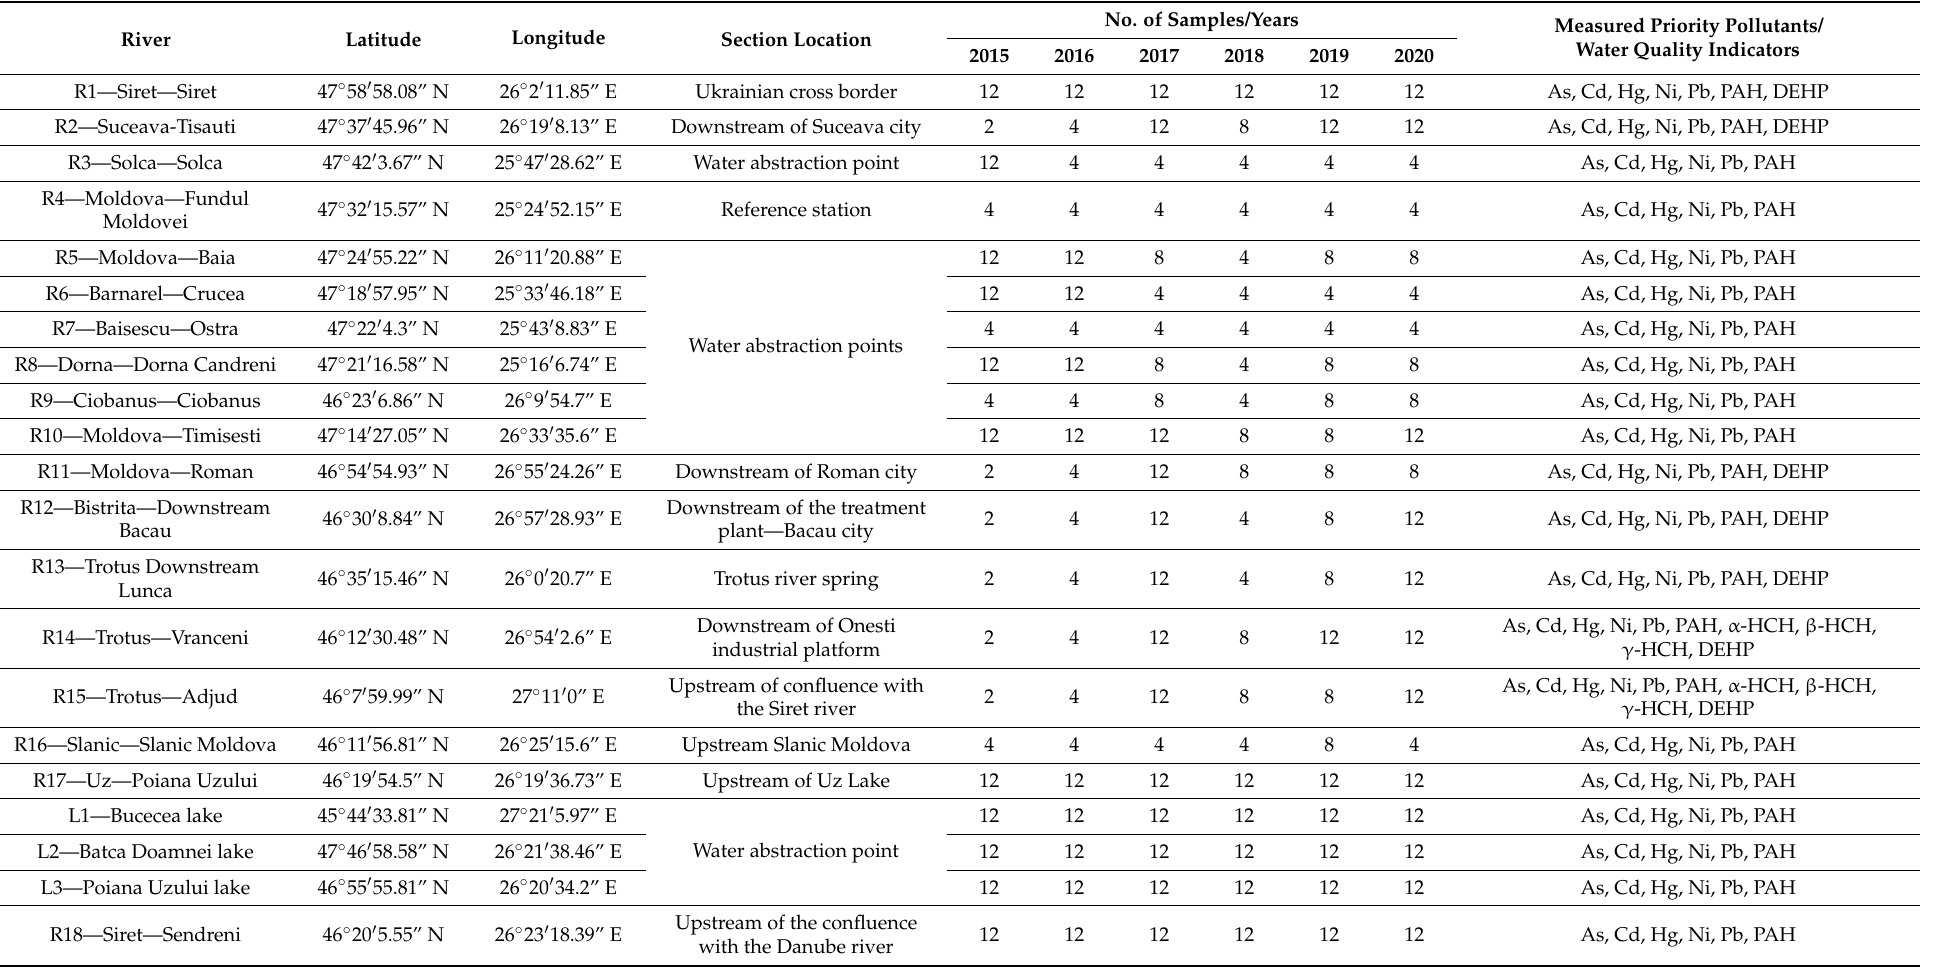
Table 1. Sampling points and water quality indicators assessed, during the period